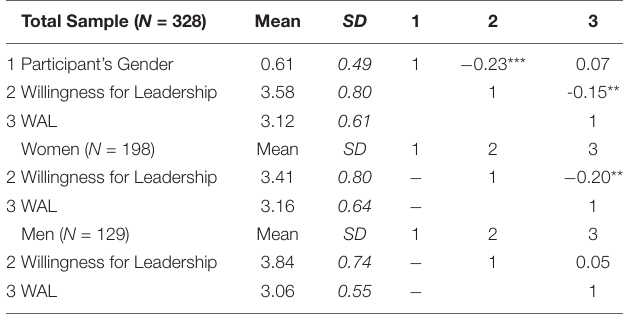
TABLE 1 | Study 1 descriptive statistics and correlations.